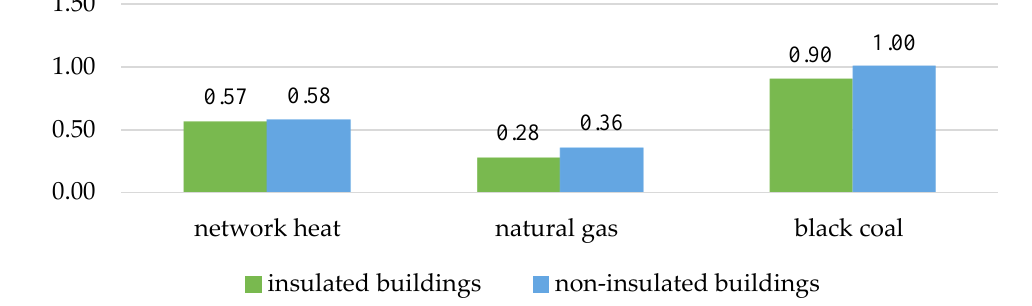
Figure 4. Use of energy carriers as dependent on the thermal insulation of a building in 2020 (GJ/m 2 ). Own elaboration based on Central Statistical Office [56].